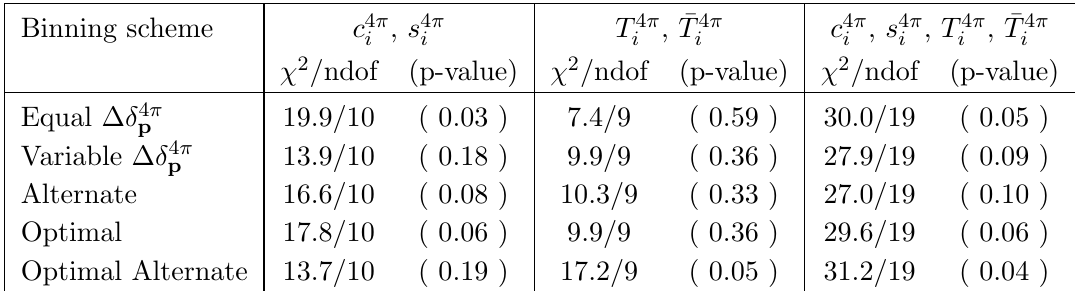
Table 6 . The compatibility of the measured 4 (cid:25) (cid:6) hadronic parameters with the model predictions for all binning schemes with N =